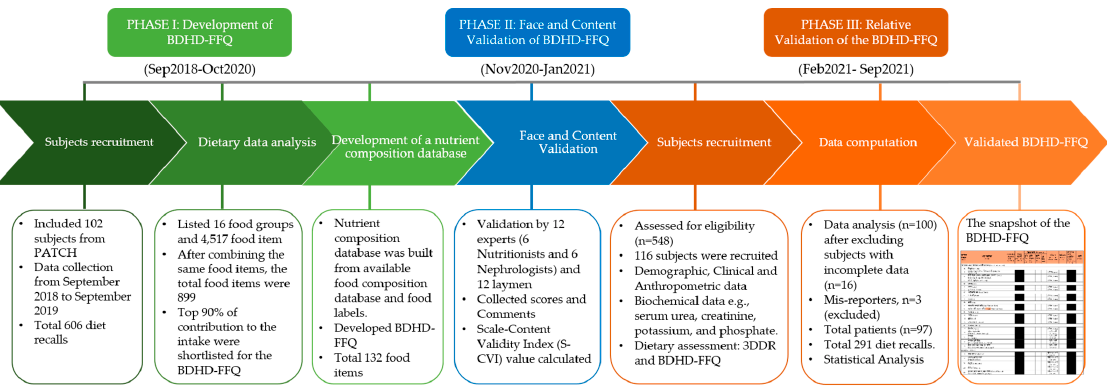
Figure 1. Development and validation process algorithm of the BDHD-FFQ.